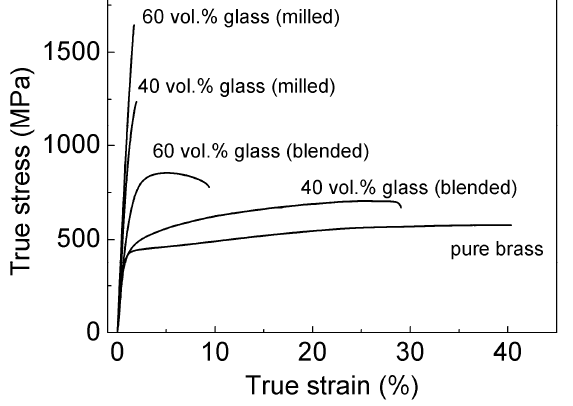
Zr Ti Si Sn 59 20 16 2 3